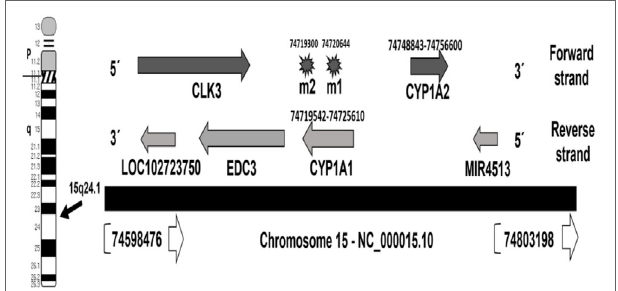
FigUre 1 | Map locations of CYP1A1 locus and m1 and m2 polymorphisms on chromosome 15—NC_000015.10 region. The locations are updated to hg38 human genome assembly release (31).